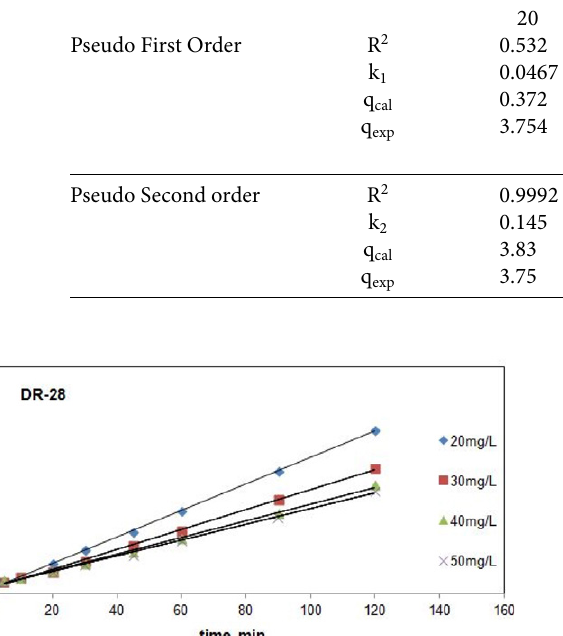
Table 4. Pseudo first order and pseudo second order kinetic model constants for DB-22 adsorption using the ad- sorbent KZF Kinetic model